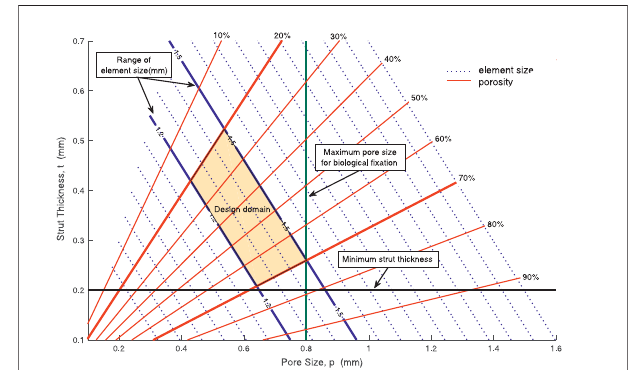
FIGURE 9 | Convergence history of the objective in optimization of the BS